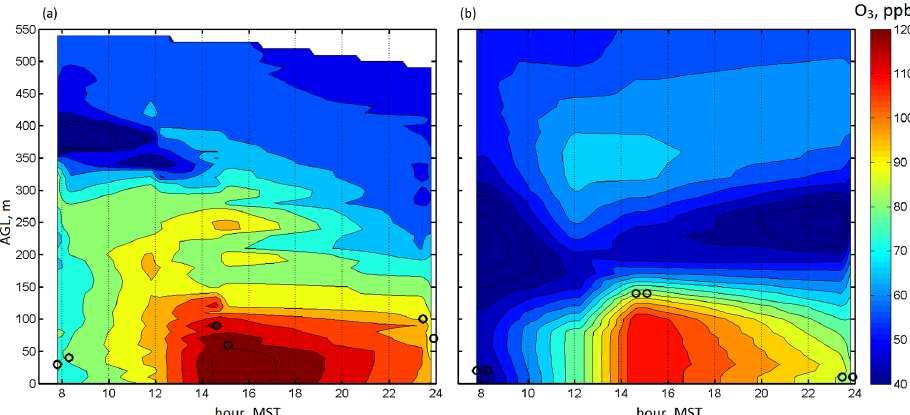
Figure 6. Vertical O 3 distribution above the Horse Pool site, 5 February 2013: (a) measured by the tethersonde; (b) modeled. There are data from eight tethersonde profiles in panel (a) . The O 3 mixing ratios were interpolated for other times of the day. Black circles show PBL heights determined using the vertical gradient of the virtual potential temperature. For the third and fourth tethersonde launchings, the meteorological data are not available to calculate the PBL heights.